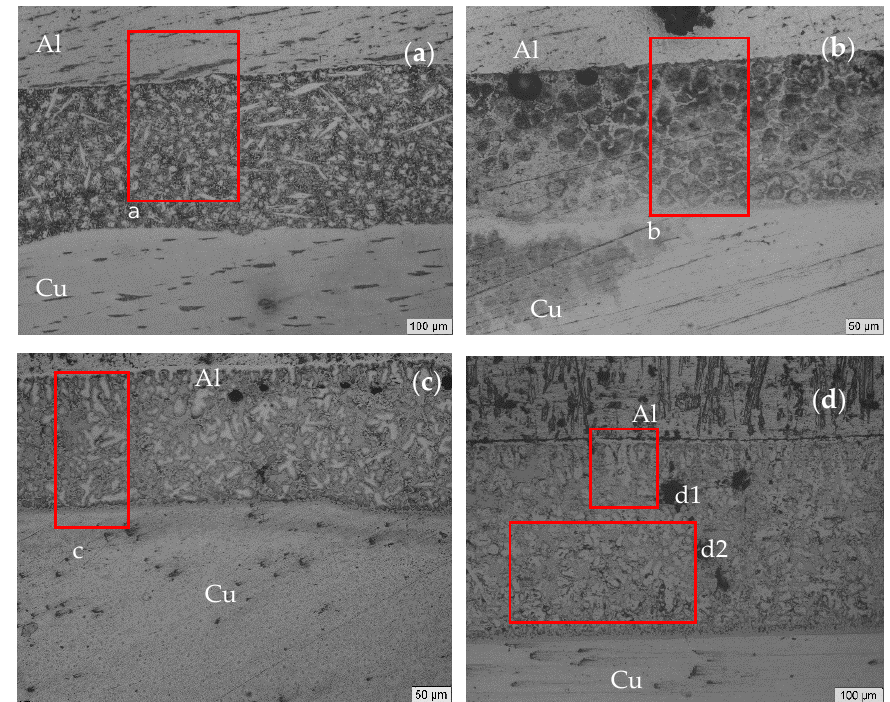
Figure 6. Microstructure of brazed joints under di ff erent Al-substrate-side heat dissipation rate: ( a ) Al-side heat dissipation rate 2 K / s; ( b ) Al-side heat dissipation rate 5 K / s; ( c ) Al-side heat dissipation rate 7 K / s; ( d ) Al-side heat dissipation rate 9 K /